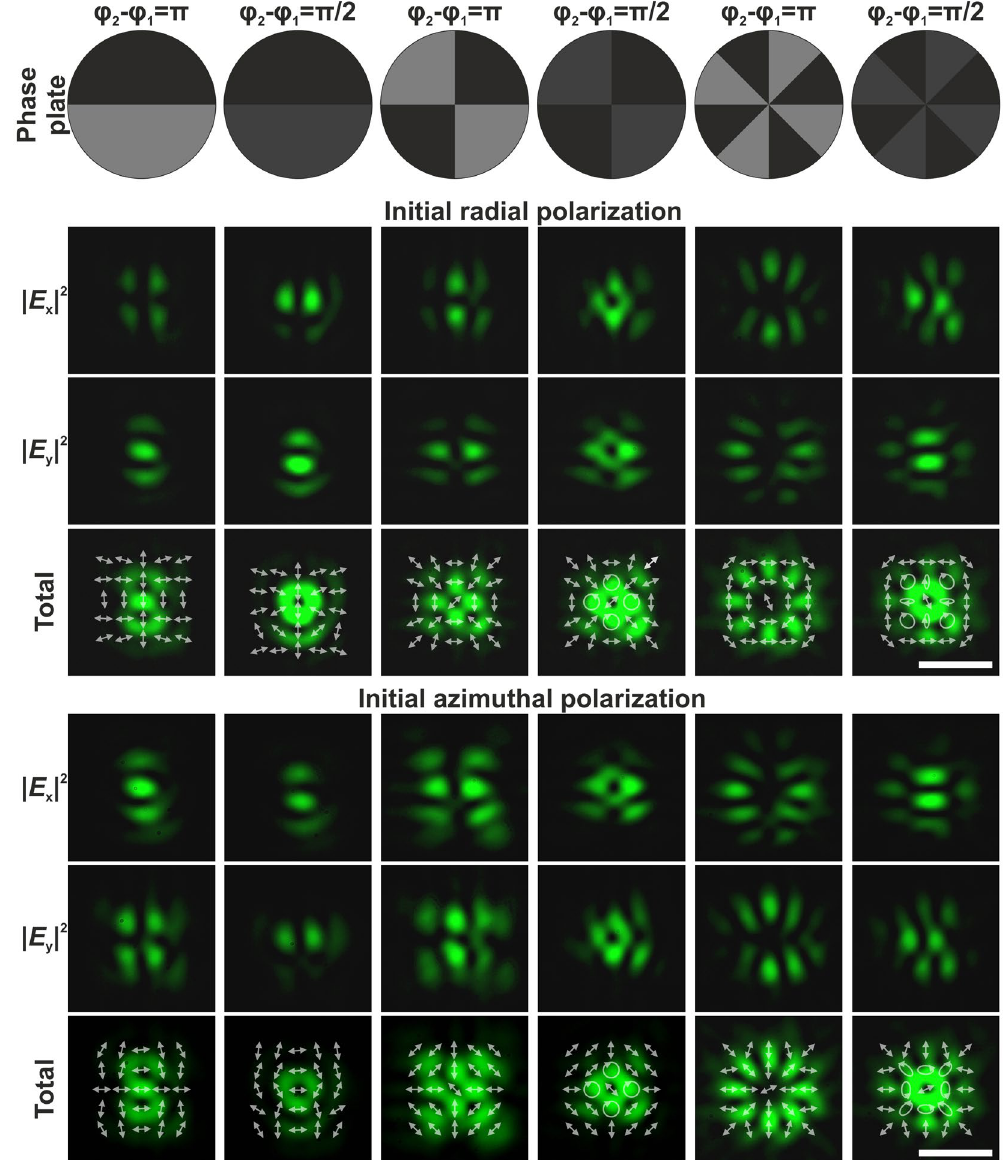
Figure 7. Experimentally obtained transverse component distributions of the focused radially/azimuthally polarised laser beam passed through different binary multi-sector phase plates. The intensity distributions were formed in the focal plane of a microobjective with NA eff = 0.3. The arrows show the schematic polarisation distributions. The scale bar is 500 μ